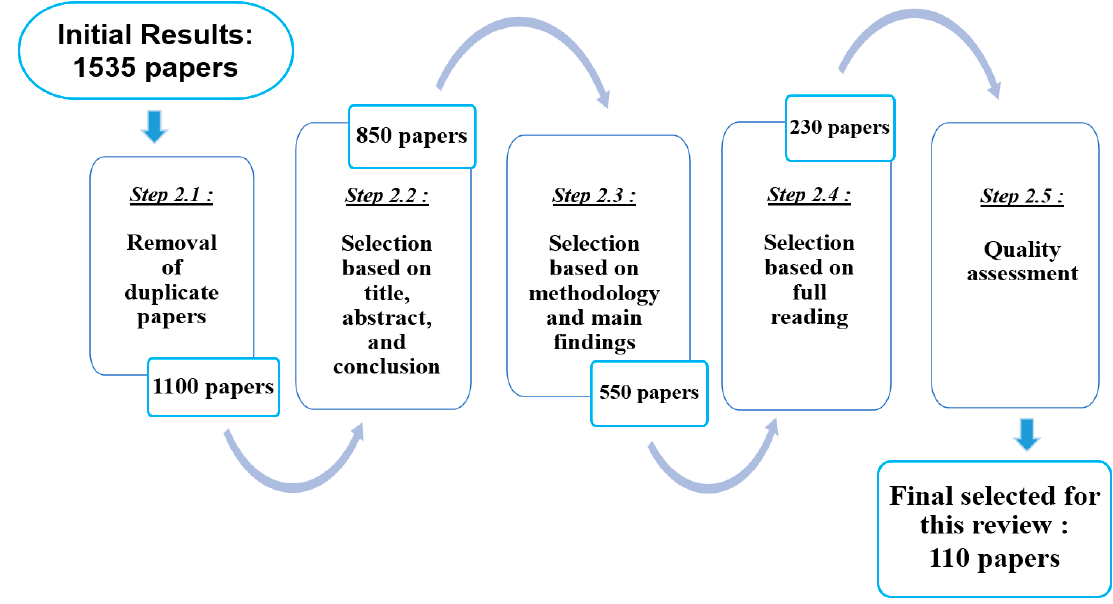
Figure 6. Graphical description of paper selection methodology.